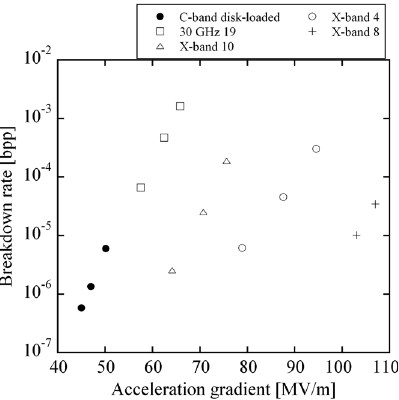
FIG. 13. Breakdown rate per pulse as a function of the acceleration gradient. The solid circles represent the case of the C -band disk-loaded-type accelerating structure, and the other markers represent the breakdown rates of the various structures in Ref. [16].